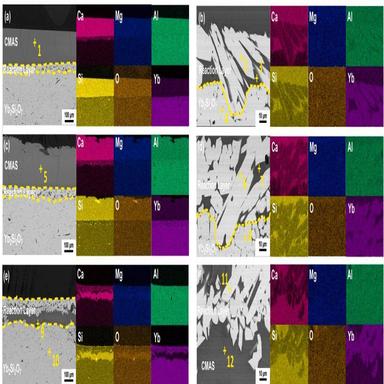
Cross-sectional SEM images and corresponding elemental mappings of Yb2Si2O7 after CMAS corrosion at 1300 ◦C for (a,b) 2 h, (c,d) 12 h and (e,f) 24 h.